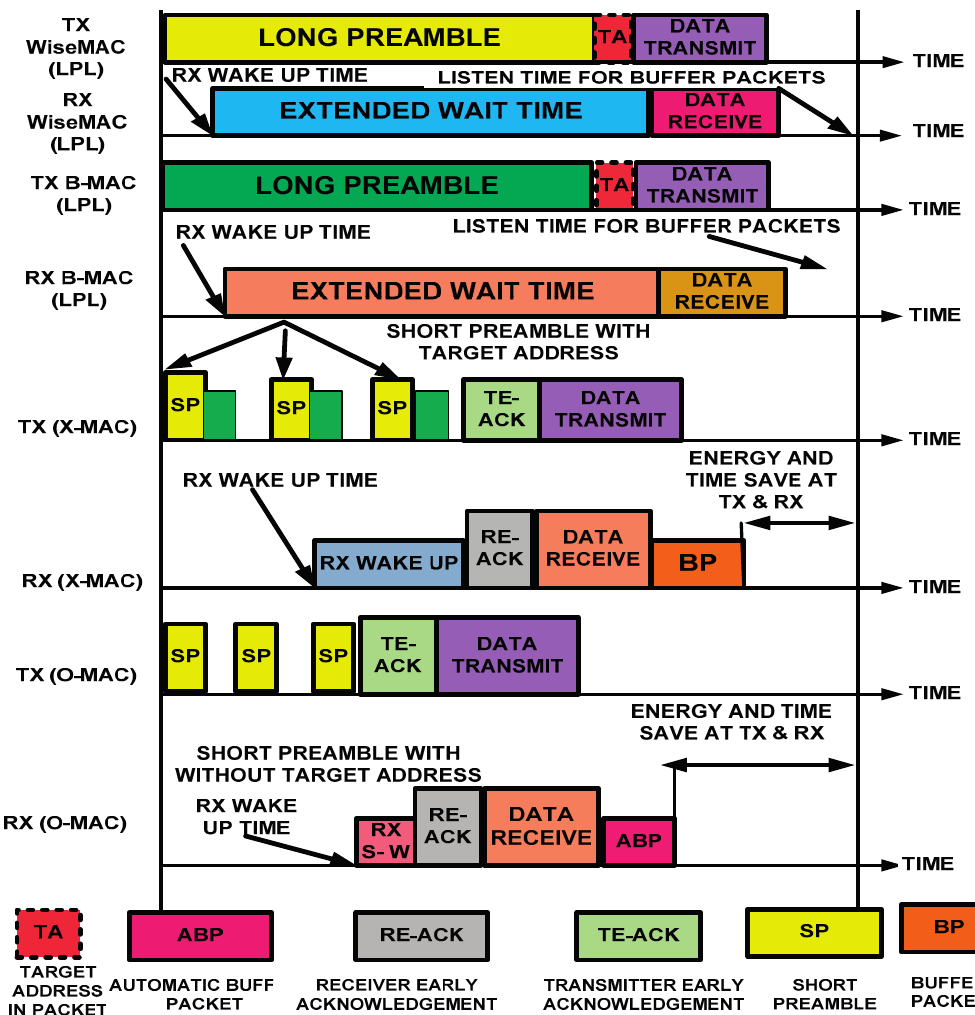
Figure 4. Timeline comparison of low-duty-cycle hybrid MAC